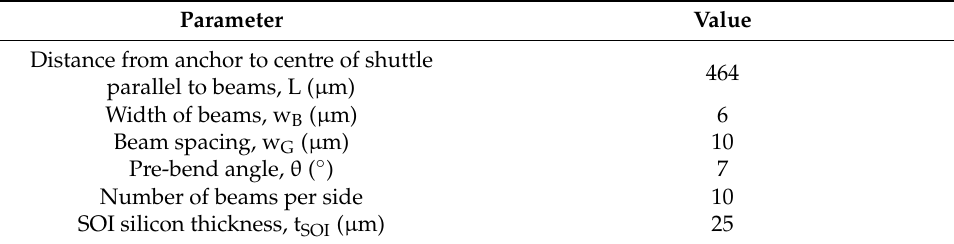
Table 2. Material properties of the SOI and pad metal layers as extracted from [3,14]. The below data was assumed to be at a reference temperature of 22 °C. Note that directions ‘x’ and ‘y’ are in- plane, whereas ‘z’ is out-of-plane.